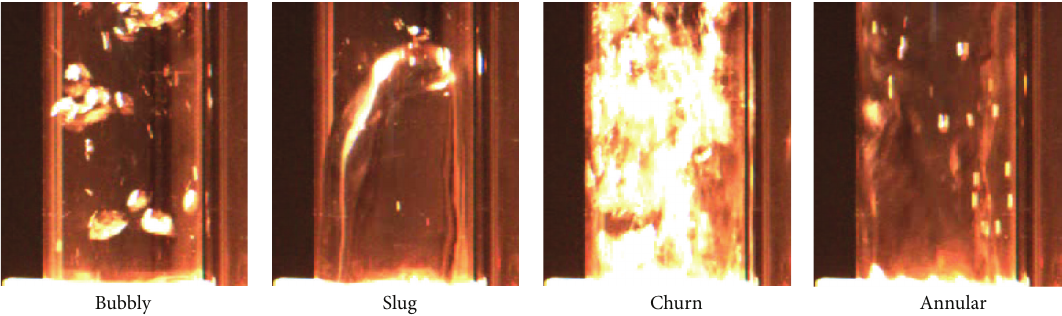
Figure 2: Experimental flow regime identification.